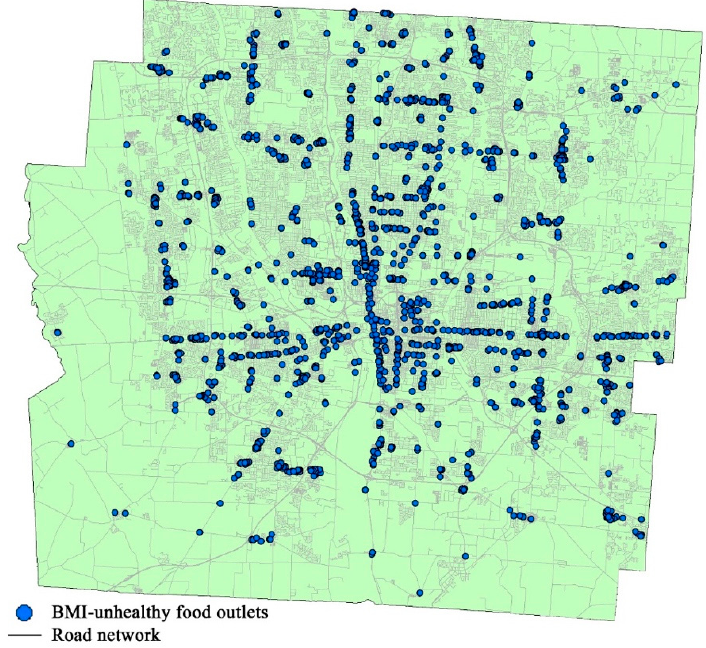
Figure 2. The study area (Franklin County) and the location of BMI ‐ unhealthy food outlets.